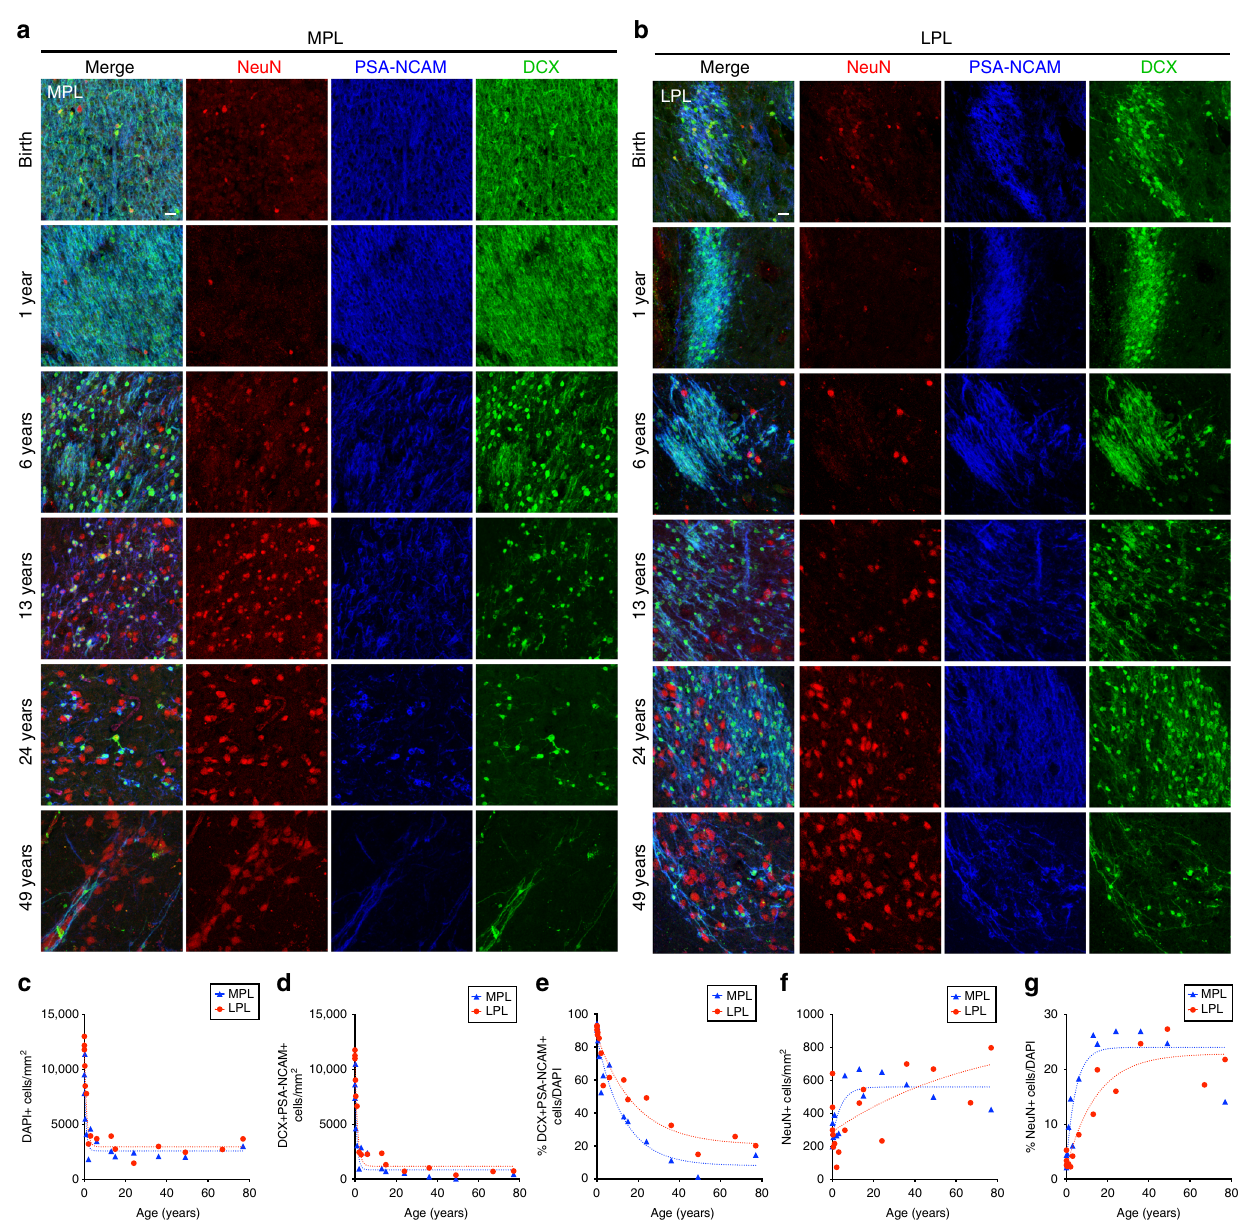
Fig. 4 DCX + PSA-NCAM + neurons decrease and NeuN + neurons increase in the PL across life. a , b DCX + PSA-NCAM + cells and NeuN + cells in the MPL ( a ) and LPL ( b ) from birth to 24 years of age. c – g Quanti fi cation of cells in the MPL and LPL across life. Each data point corresponds to one individual; line indicates non-linear exponential fi t. c Density of DAPI + nuclei in the PL from birth to 77 years. d Density of DCX + PSA-NCAM + DAPI + cells in the PL from birth to 77 years. e Percentage of DCX + PSA-NCAM + DAPI + cells in the PL from birth to 77 years. f Density of NeuN + cells in the PL from birth to 67 years. g Percentage of NeuN + DAPI + cells in the PL from birth to 67 years. Scale bars: 20 µ m ( a , b